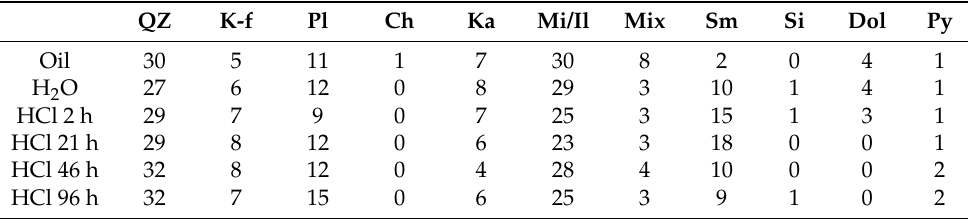
Table 2. Mineralogical composition of shale samples after exposure to oil, water (after 96 h) and 1 M HCl (after 2, 21, 46, 96